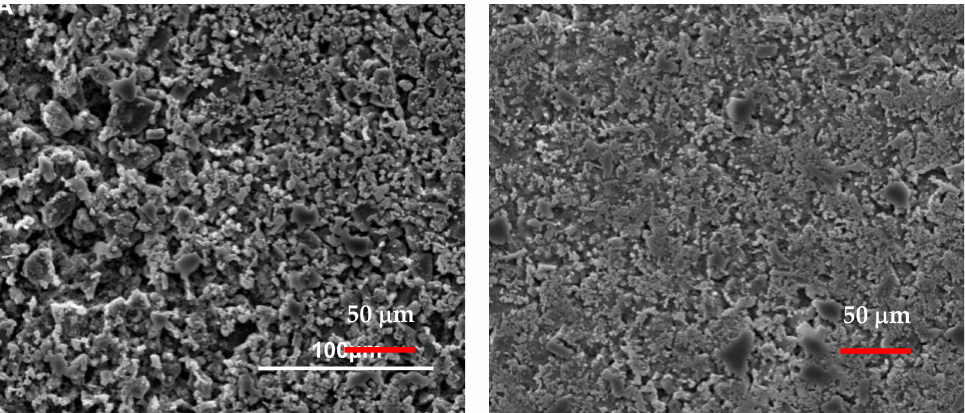
Figure 7. Hydration rates and normalized mean relaxation rates four samples calculated by DTA / TG measurements.